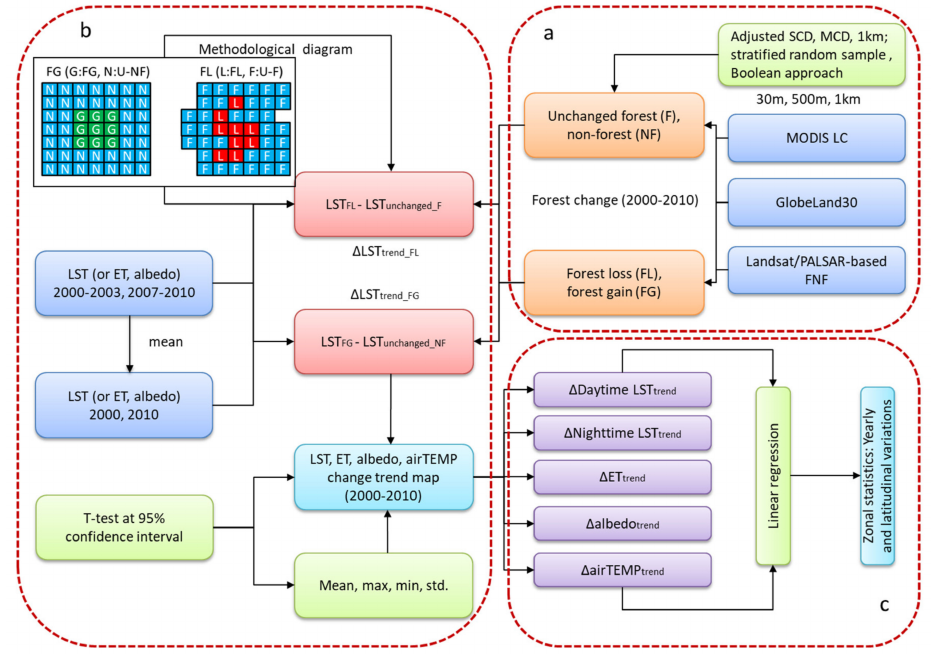
Figure 2. Workflow diagram of actual change used to analyze the yearly change di ff erences in daytime and nighttime land surface temperature (LST), evapotranspiration (ET), and albedo of forest loss (FL: “L”) and forest gain (FG: “G”) from 2000–2010 based on the improved spatial pattern change method (N: U-NF, “no-change non-forest”; F: U-F, “no-change forest”). ( a ): Three dataset-based forest change data; ( b ): An improved spatiotemporal analysis method for LST change due to forest cover change; ( c ): The relationship between the yearly change di ff erences in daytime and nighttime LST, ET, and albedo of forest change and their spatio-temporal statistical